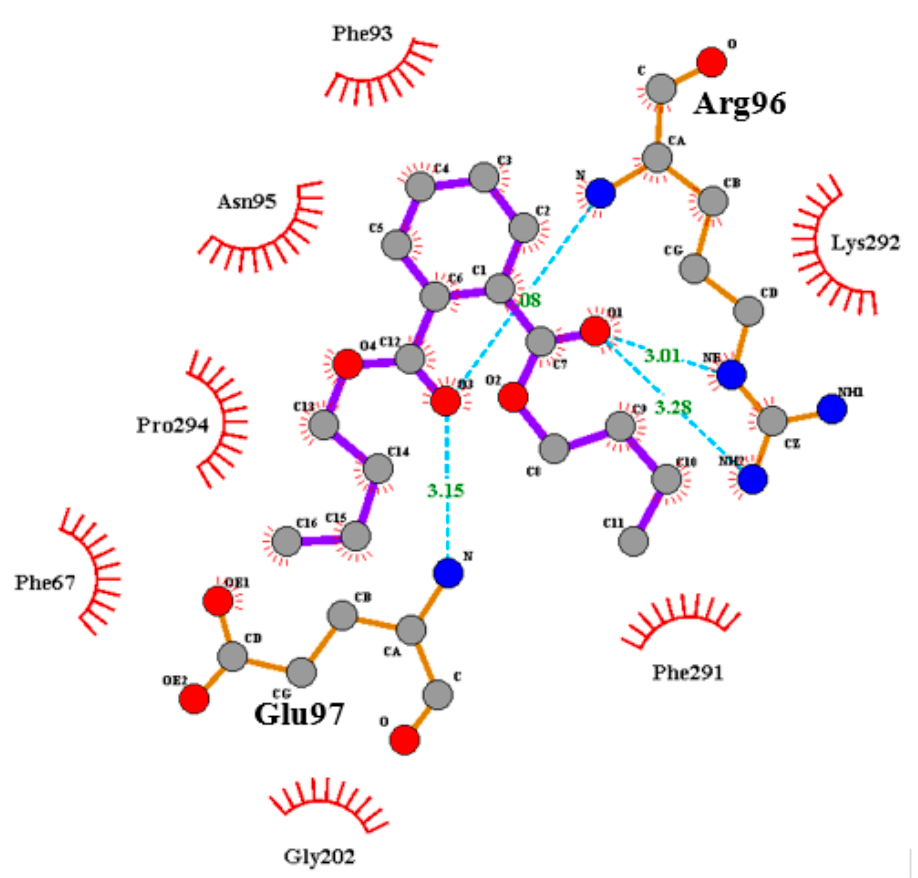
Table 3. A summary of DBP-interacted amino acid residues on P1 and P2 [25] as analyzed by Mo- legro docking software. Enclosed and non-enclosed residues are hydrogen bond formations and hydrophobic interactions between GSK-3 β with DBP, respectively.